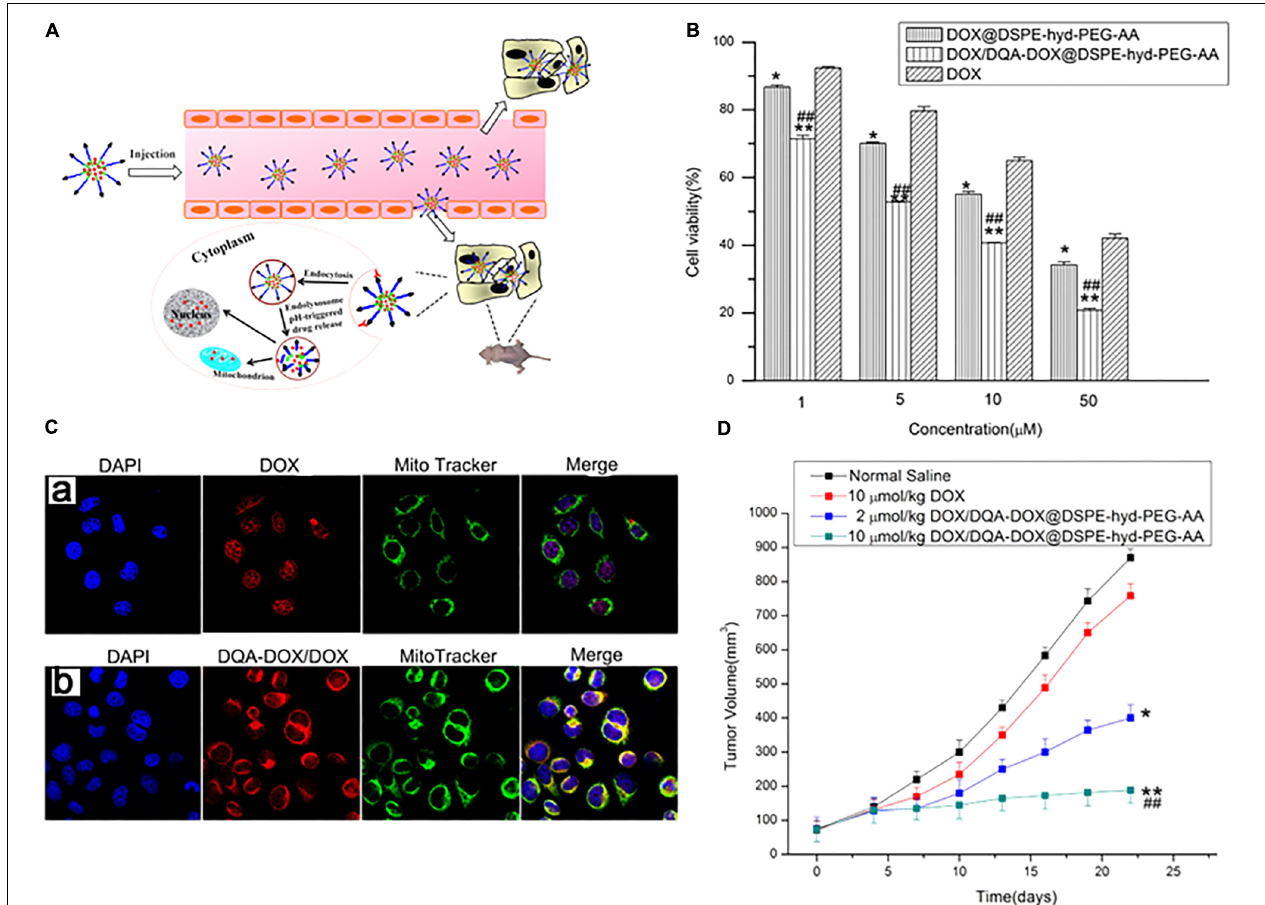
FIGURE 8 | (A) Schematic representation of pH-responsive DOX/DQA-DOX@DSPE-hyd-PEG-AA for intracellular doxorubicin delivery in breast cancer. (B) Cytotoxicity of DOX, DOX/DQA-DOX@DSPE-hyd-PEG-AA and DOX@DSPE-hyd-PEG-AA in A549 cells at 48 h. (C) The distribution of DOX in mitochondria after A549 cells were treated with DOX@DSPE-hyd-PEG-AA (a) and DOX/DQA-DOX@DSPE-hyd-PEG-AA (b) at 37 ◦ C for 4 h. (D) In vivo antitumor activity of DOX/DQA-DOX@DSPE-hyd-PEG-AA in athymic nude mice xenografted with MDA-MB-231/ADR cells. Images were adapted with permission from reference (Song et al., 2015). Data are presented as mean ± SD, n = 4; ∗ p < 0.05 and ∗∗ p < 0.01, vs. normal saline; ## p < 0.01, vs. free